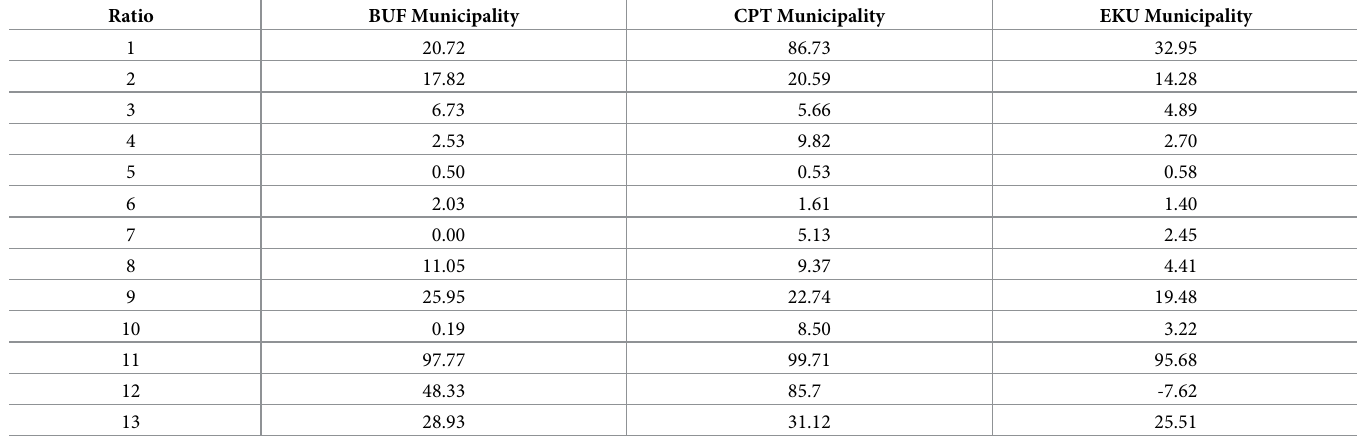
Table 2. Example of financial ratio input features for three South African municipalities in 2010. The BUF municipality had a qualified audit opinion while CPT and EKU has unqualified audit opinions.